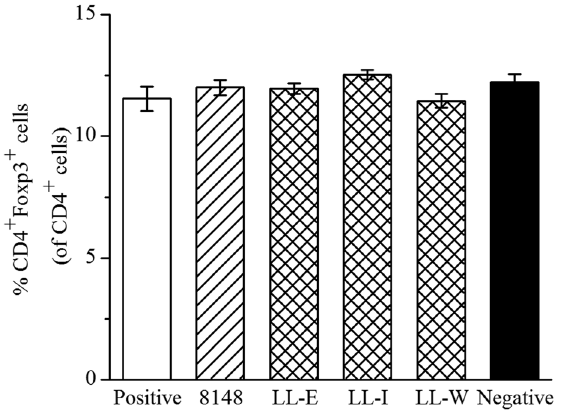
Figure 7. Measurement of CD4 + Foxp3 + T cells in the spleen. On day 12, the percentage of CD4 + Foxp3 + T cells in the spleen from the respective groups were evaluated. Results were expressed as means 6